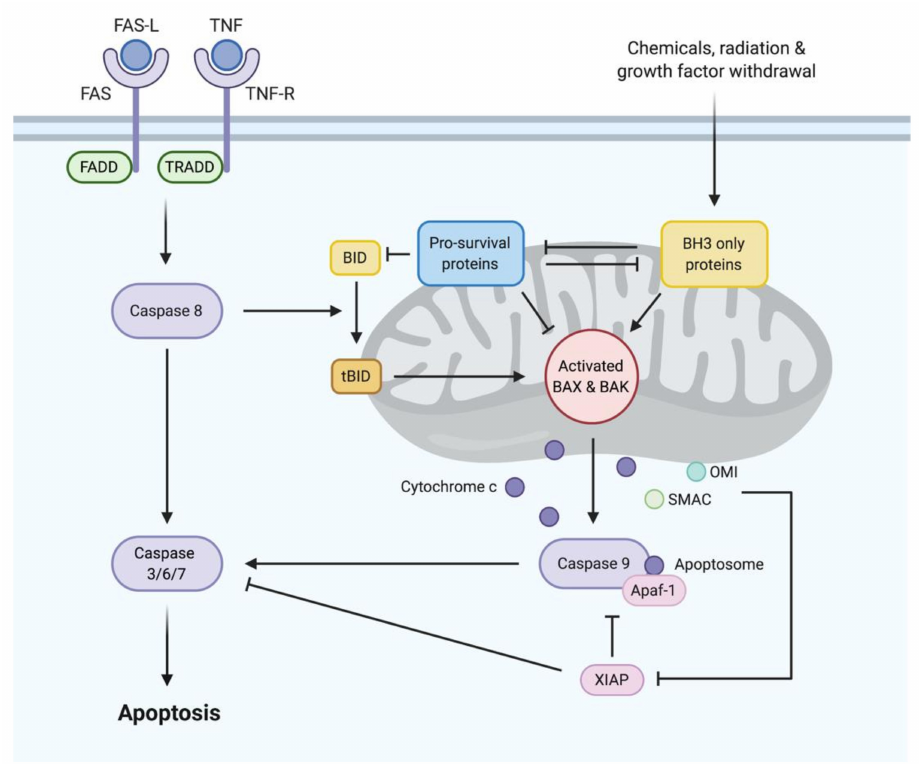
Figure 1. The extrinsic and intrinsic pathways to apoptosis. The extrinsic pathway is initiated when death receptor ligands (e.g., first apoptosis signal ligand [FAS-L], tumor necrosis factor (TNF)) bind to their cognate death receptors (e.g., first apoptosis signal [FAS], TNF receptor [TNFR]) on the plasma membrane, resulting in activation of caspase 8 via FAS-associated death domain protein (FADD) with or without TNFR-associated death domain protein (TRADD). The intrinsic pathway is triggered when diverse stress signals (e.g., DNA damage, growth factor deprivation) activate pro-apoptotic BH3-only proteins, which carry out their pro-apoptotic function by neutralizing pro-survival B-cell lymphoma 2 (BCL2) family proteins or, when these pro-survival proteins are saturated or absent, by directly activating BCL-associated X protein (BAX) and BCL2 homologous antagonist / killer (BAK), causing mitochondrial outer membrane permeabilization (MOMP). MOMP results in the release of a range of apoptogenic factors, including cytochrome c, from the intermembrane space of the mitochondria into the cytoplasm. In the cytoplasm, cytochrome c binds to apoptotic protease activating factor 1 (APAF1) to form the apoptosome, which mediates the activation of caspase 9. The extrinsic and intrinsic pathways converge with initiator caspases (e.g., caspase 8, caspase 9) activating executioner